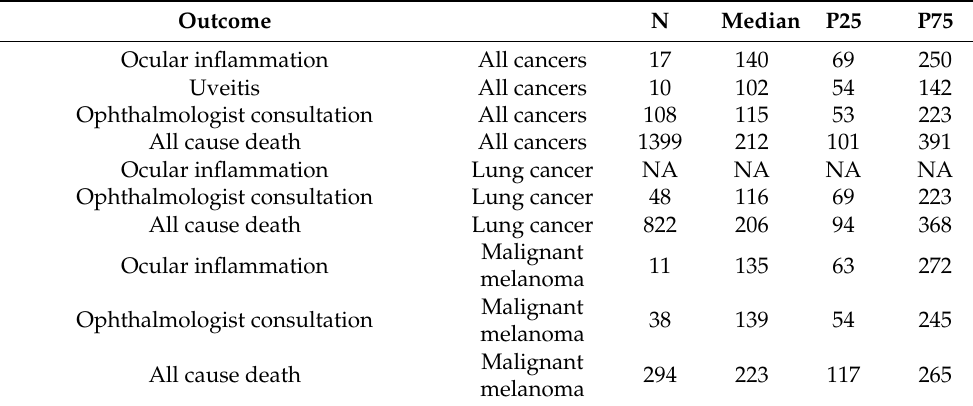
Table 4. Time to event from first ICI administration.